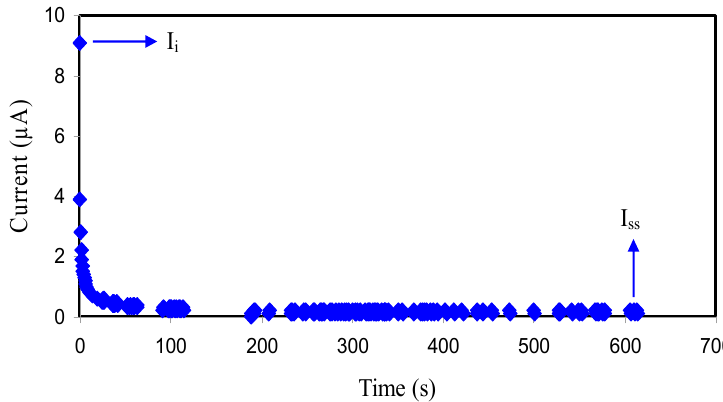
Figure3. VariationofcurrentwithrespecttotimeforthecellassembledwithSS / CS:PVA:LiClO 4 :glycerol / Figure 3. Variation of current with respect to time for the cell assembled with SS/CS:PVA:LiClO 4 :glycerol/SS.